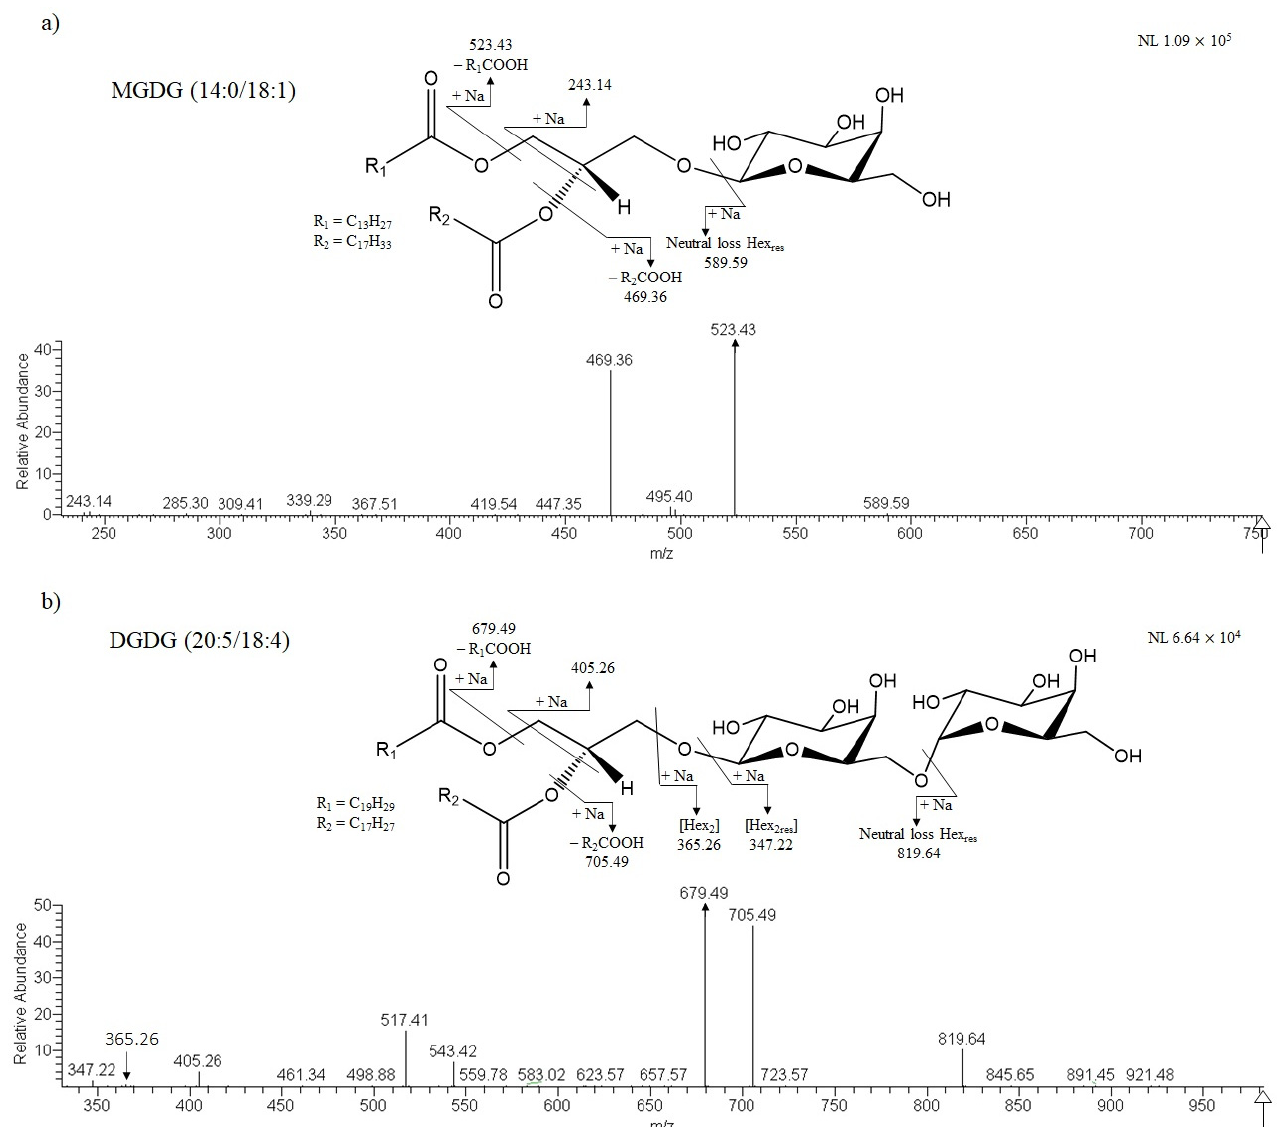
Figure 1. Illustrative tandem mass spectra of ( a ) Monogalactosyldiacylglycerol (MGDG) (14:0/18:1) at m/z 751.53 and ( b ) Digalactosyldiacylglycerol (DGDG) (20:5/18:4) at m/z 981.56, as [M + Na] + ions. In addition to the product ions indicated in ( b ), the MS/MS spectra for DGDG (20:5/18:4) also showed clear product ions for the combined neutral loss of a hexose residue and each of the acyl chains as neutral carboxylic acids. These losses correspond to product ions at m/z 517.41 (-Hexose residue and R 1 COOH) and m/z 543.42 (-Hexose residue and R 2 COOH). NL: normalization level (base peak intensity).